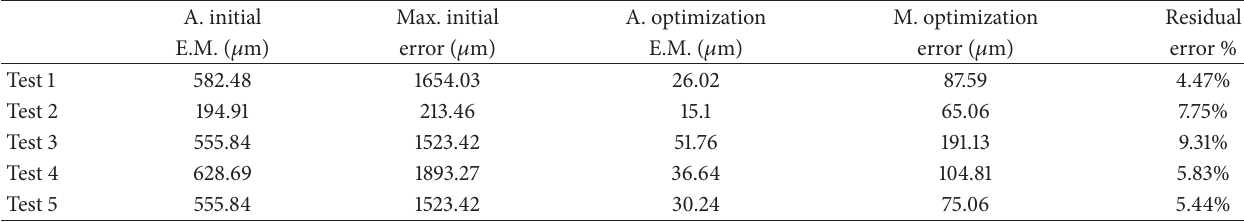
Table 11: Optimization results depending on the method used.